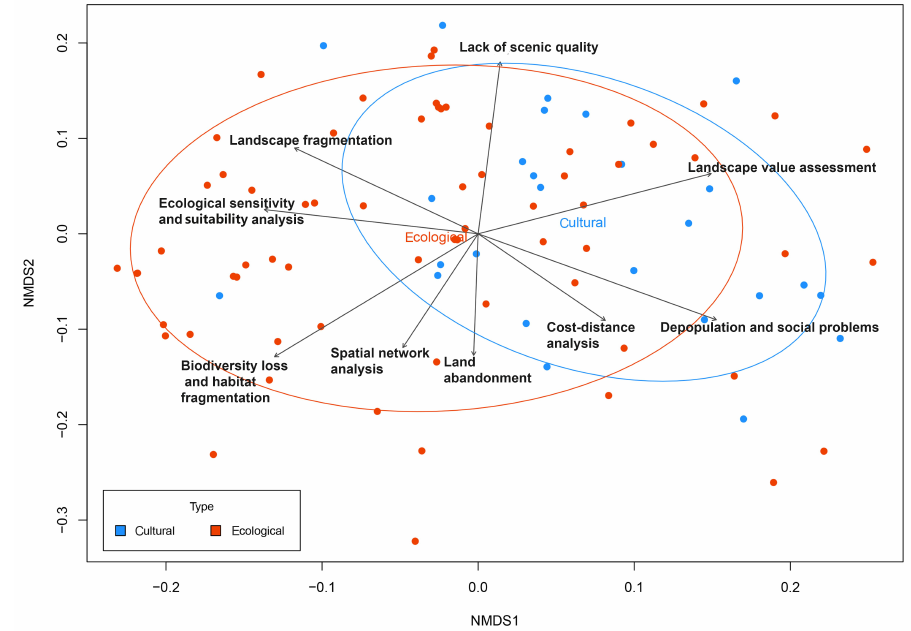
Figure 4. Dissimilarity between corridors: Problems addressed (e.g., landscape fragmentation), approaches (e.g., ecological sensitivity and suitability analysis), number of stakeholders, stakeholder type and corridor size. Each case is represented by a dot (cultural corridors are represented by blue dots, ecological corridors by red dots). All variables are represented by a distance index between cases in a non-metric multidimensional scaling (NMDS) ordination plot. The ordering of the cases is represented in two dimensions (NMDS1, NMDS2). Arrows indicate the main variables explaining the ordination (p = 0.001) parameters recorded in this